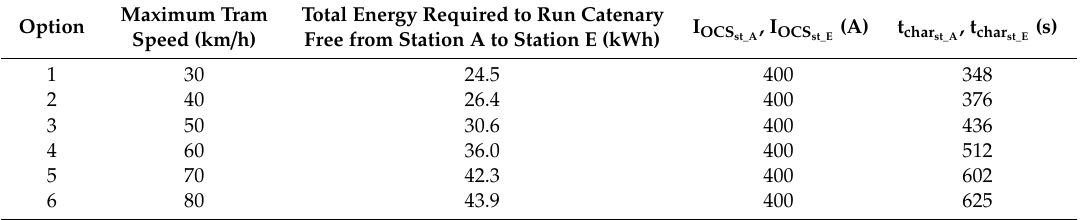
Table 5. Results for the catenary free section (di ff erent tram speeds).